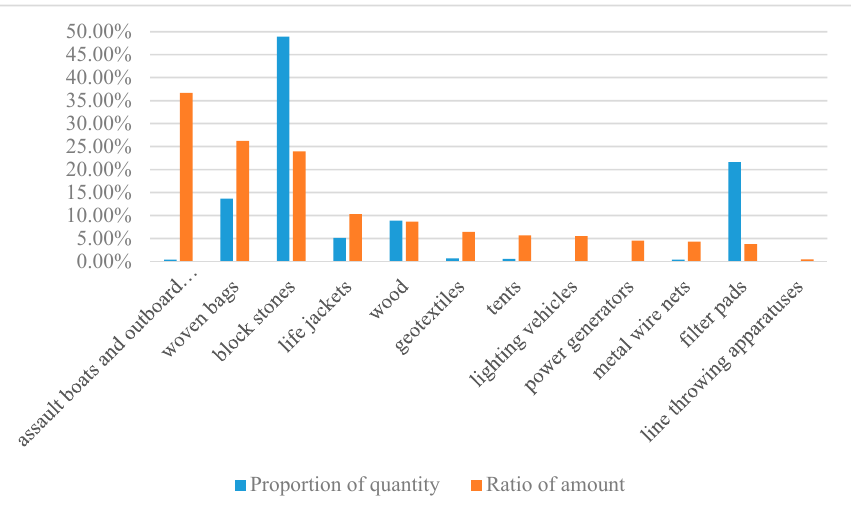
Figure 2. The statistics on the 12 classes of the Jiangsu provincial-level flood control materials. The proportion of quantity: the proportion of the amount of flood control materials in the total amount of provincial-level flood control materials in HFCMRC Zhenjiang Warehouse. The ratio of amount: the proportion of funds for flood control materials procurement in the total funds for provincial-level flood control materials procurement in the HFCMRC Zhenjiang Warehouse.